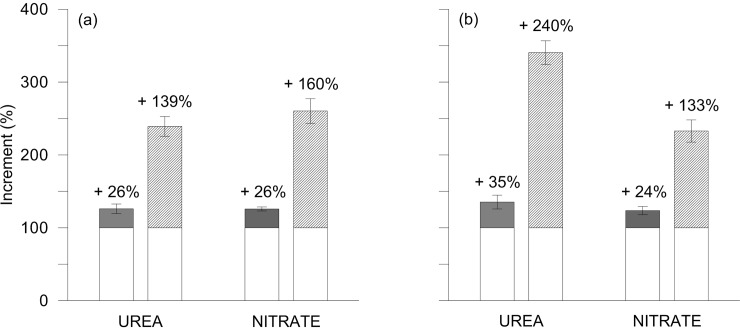
Increment of gliadins and glutenins in durum wheat mature grains under UREA and NITRATE fertilisation treatments respect to CONTROL.Percentage increments of gliadins (grey chart) and glutenins (diagonal lines; LMW-GS plus HMW-GS fractions) with respect to CONTROL (white chart) in durum wheat fertilized with urea (UREA) and calcium nitrate (NITRATE) at the rate of 150 kg N ha-1 in 2011 (a) and 2012 (b). Data are averages ± standard errors, for n = 3 independent replicates.